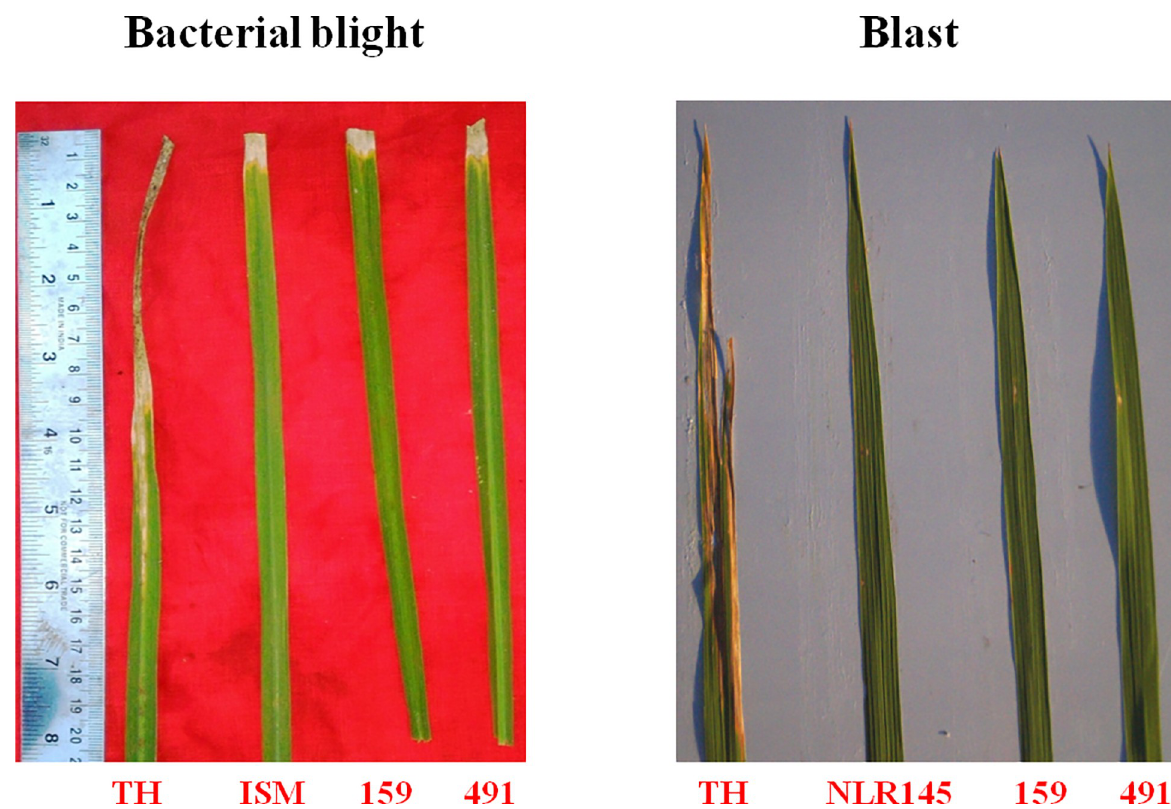
Fig 3. Leaves of ICF 3 lines along with parents showing symptoms of BB and